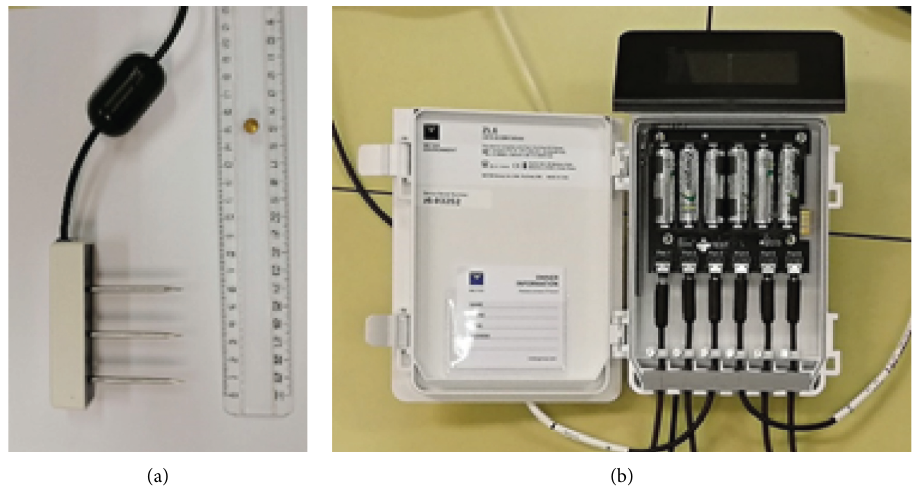
Figure 5: The Teros 12 moisture sensor (a) and the ZL6 datalogger